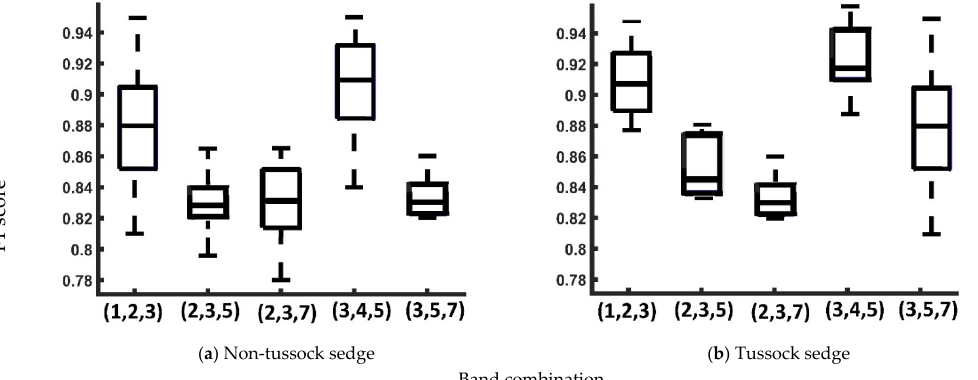
Figure 8. Box plot of F1 score for the different band combinations. In each box, the central mark is the median, and the edges are the first and third quartiles.